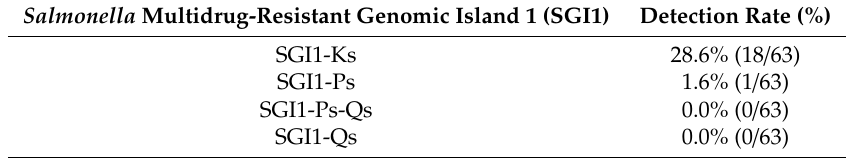
Table 2. Rate of detection of Salmonella multidrug-resistant genomic island 1 in Salmonella Kentucky